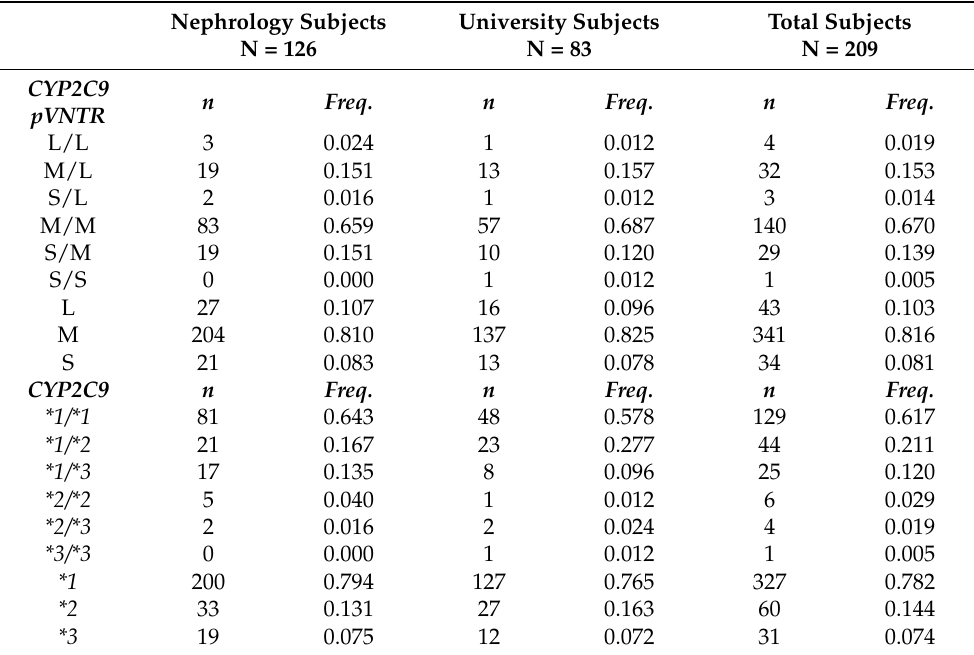
Table 1. Genotype and allelic frequency of CYP2C9 pVNTR *2 and *3 in a Spanish population (n = 209).